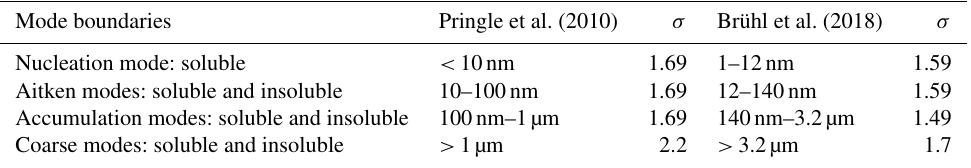
Table 1. Diameters of aerosol-mode boundaries in the GMXe sub-model for tropospheric (Pringle et al., 2010) and volcanic stratosphere conditions (Brühl et al., 2018), including the corresponding mode distribution width ( σ